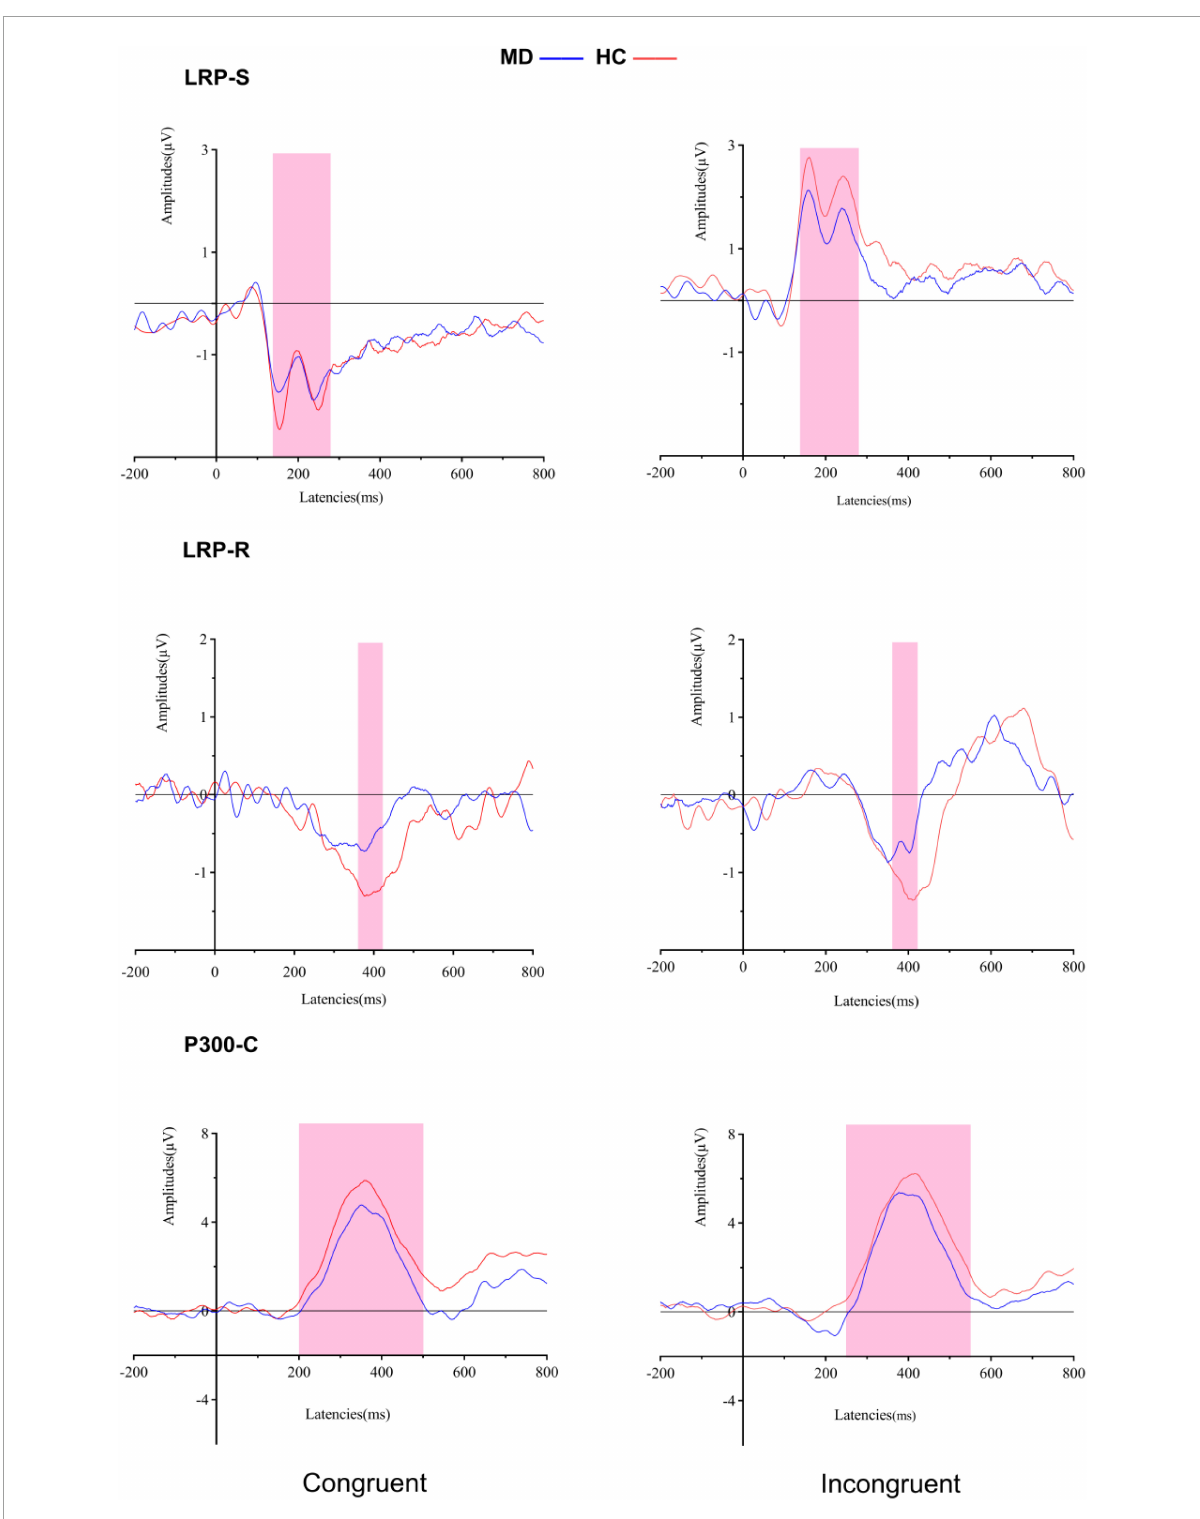
FIGURE4 Grand averaged ERPs of both groups under congruent and incongruent condition (LRP-S is represented for the perceptual coding stage: 140–280 ms for all conditions; LRP-R is represented for the response execution stage: 370–400 ms for congruent condition, and 380–410 ms for incongruent condition). P300-C at the Cz electrode site is represented for transformation stage of stimulus and response (200–500 ms for congruent condition, and 250–550 ms for incongruent condition). MD, major depression group; HC, healthy control